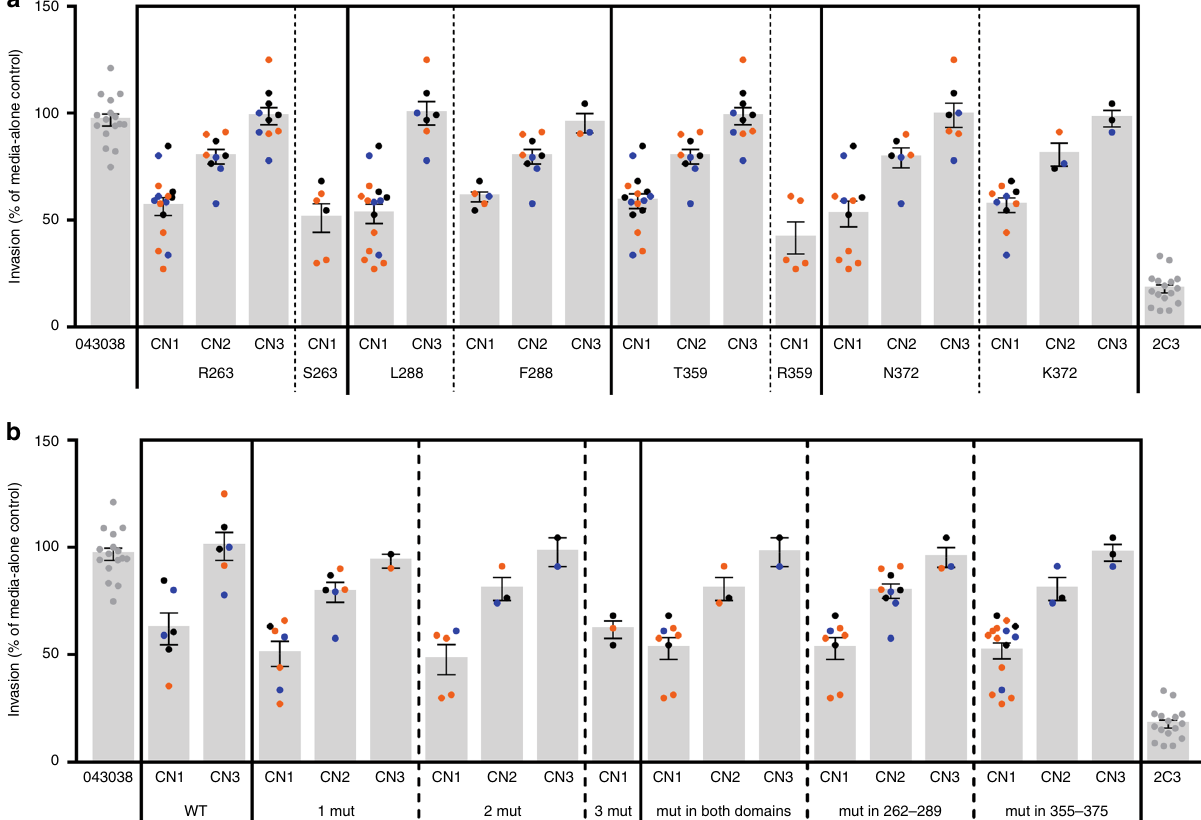
Fig. 3 Variation in reticulocyte invasion inhibition by human antibodies is not dependent on the DBPII sequence polymorphism of Pv isolates. Invasion percent of parasites with pvdbp copy number of 1 (CN1), 2 (CN2) or 3(CN3) in presence of 100 μ g ml − 1 of 099100 (black), 053054 (blue) or 092096 (orange) human antibodies, 043038 and 2C3 controls. Each dot represents the average invasion measured for a different isolate with 1 to 3 technical replicates per isolate. Mean ± SEM. P -values for all signi fi cant differences are reported in Supplementary Table 2. a Pooled reticulocyte invasion percent by parasites differing by their amino acids at position 263, 288, 359 and 372 within the epitopes of the humabs. For each residue, the wild type (Sal1) amino acid is indicated fi rst followed by the mutant one. b Pooled reticulocytes ’ invasion percent by parasites either without any mutation in the humab epitopes (WT) or with one (1 mut), two (2 mut), three (3 mut) mutations anywhere within the epitopes, or with any mutation in both domains or either domain 262 – 289 or 355 – 375 of the epitopes. Source data are provided as a Source Data fi le.